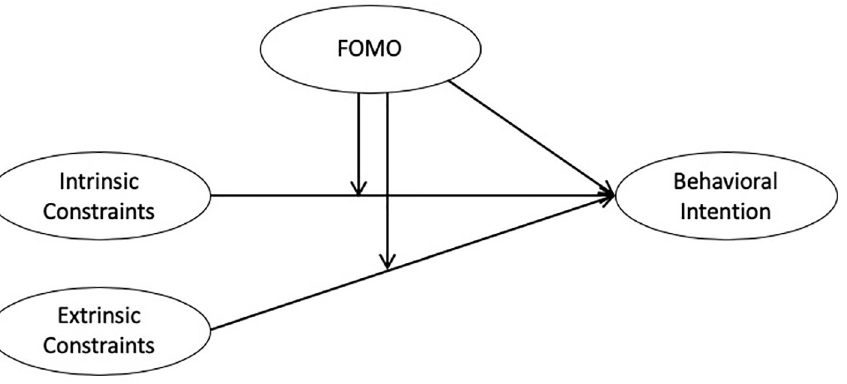
Fig 1. Structural Model of Study